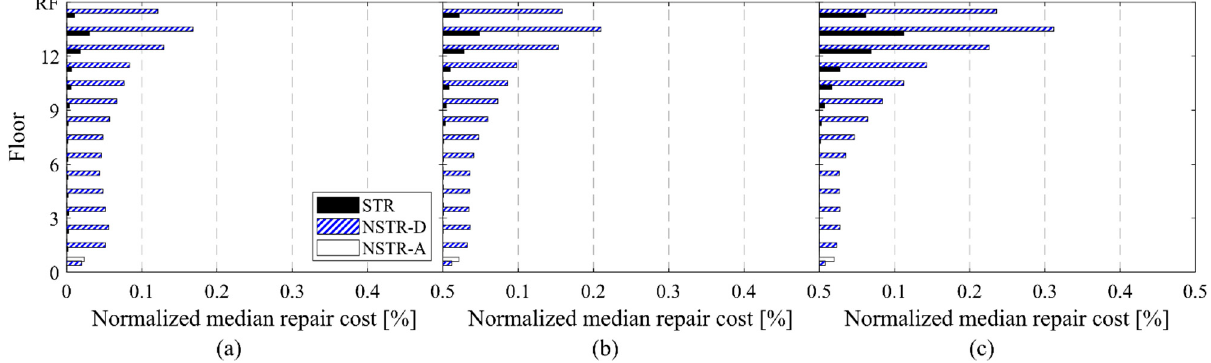
Figure 10. Normalized median repair cost of 15-story steel OMFs at SLE hazard level: ( a ) W0-OMF; ( b ) W44-OMF; ( c ) W51-OMF.